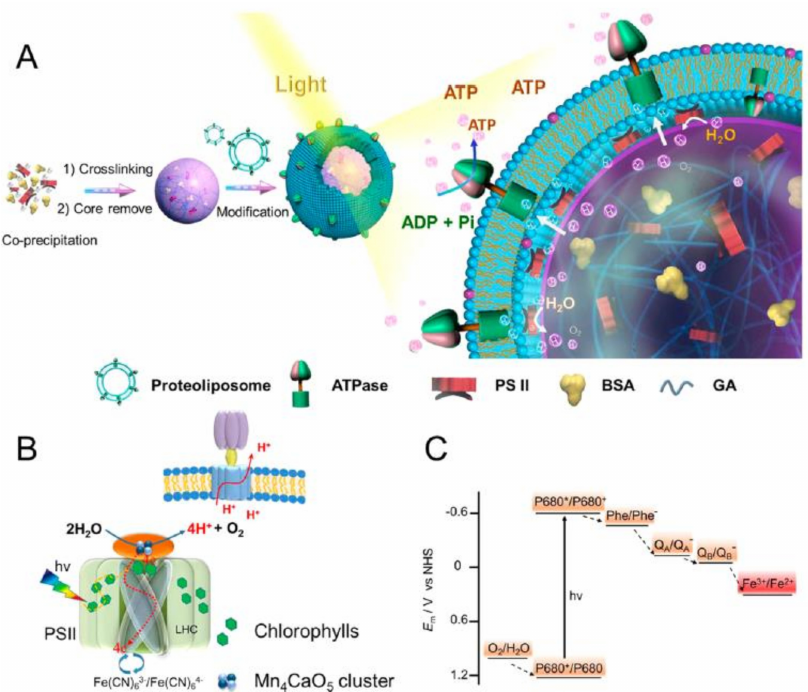
Figure 11. ( A ) Light-driven biocatalysis in an artificial chloroplast, consisting of a PSII-based microsphere and a F 0 F 1 -ATPase proteoliposome coating. For this assembly, hydrogel-like PSII-based microspheres were prepared through co-precipitation of bovine serum albumin, PSII, and calcium carbonate. After crosslinking by glutaraldehyde, the calcium carbonate core was removed. Subsequently, F 0 F 1 -ATPase proteoliposomes were coated on the surface of these microspheres. Under illumination, the entrapped PSII split water into protons, which led to the generation of ATP by the F 0 F 1 -ATPase proteoliposomes on the shell. ( B ) The photonic energy captured by the light-harvesting complex (LHC) of PSII evokes several charge separation and electron-transfer processes. The release of protons occurs at the site of a Mn 4 CaO 5 cluster. The generated proton gradient prompts the rotational catalysis of F 0 F 1 -ATPase in the coating. (C) Redox potential scheme during the electron transfer. Reprinted with permission from X. Feng, Y. Jia, P. Cai, J. Fei and J. Li, Coassembly of photosystem II and ATPase as artificial chloroplast for light-driven ATP synthesis, ACS Nano, 2016, 10(1),